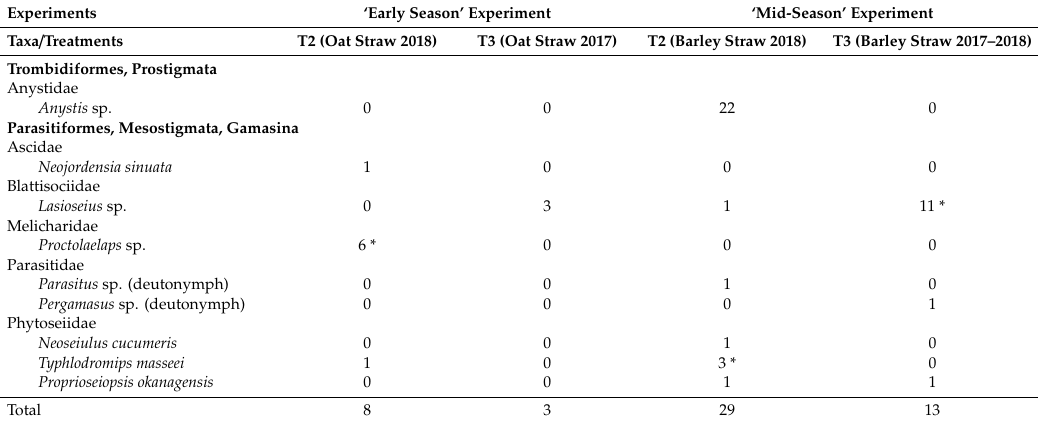
Table 3. Total mites (except Tetranychus urticae ) collected in the second and fourth evaluations at 3, 7, 11 a.m. and 3, 7, 11 p.m. on the six marked leaflets with T. urticae / plant ( n = 13 plants / treatment) in two lab experiments for di ff erent periods of time: ‘Early season’ experiment (oat straw: T2, since 2018; T3, since 2017); ‘Mid-season’ experiment (barley straw: T2, since 2018; T3, lower half layer since